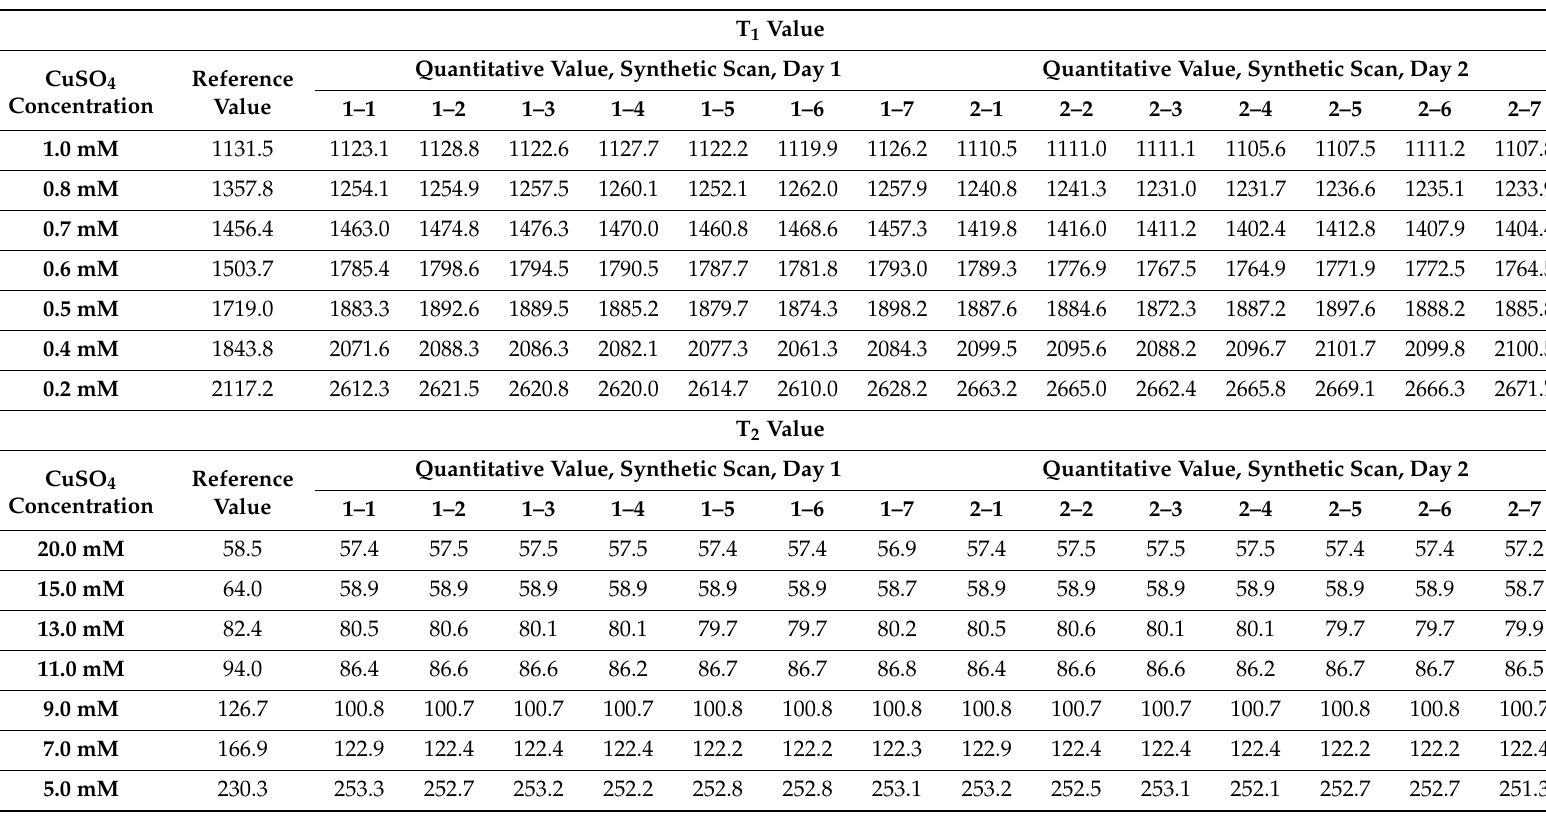
Table 2. Average quantitative values acquired using conventional magnetic resonance imaging (MRI) spin-echo sequences and synthetic MRI